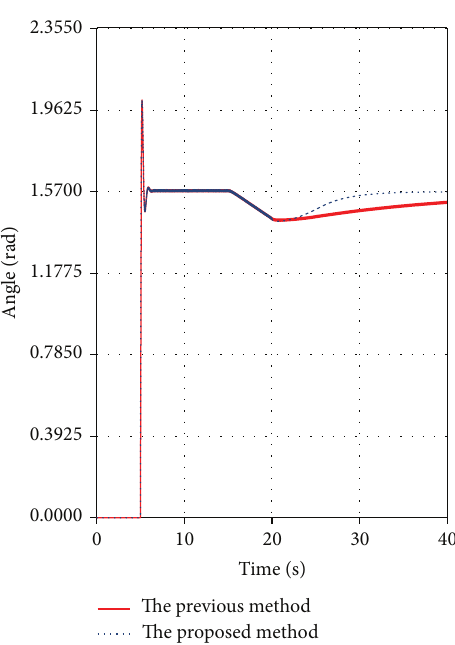
Figure 7: Experimental results for an actual DC